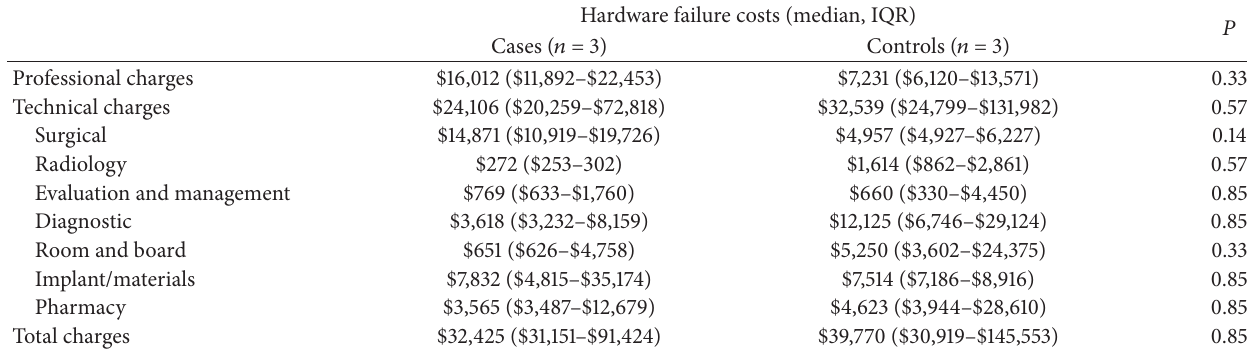
Table 6: Case versus control comparison for hardware failure costs. Hardware failure costs (median,